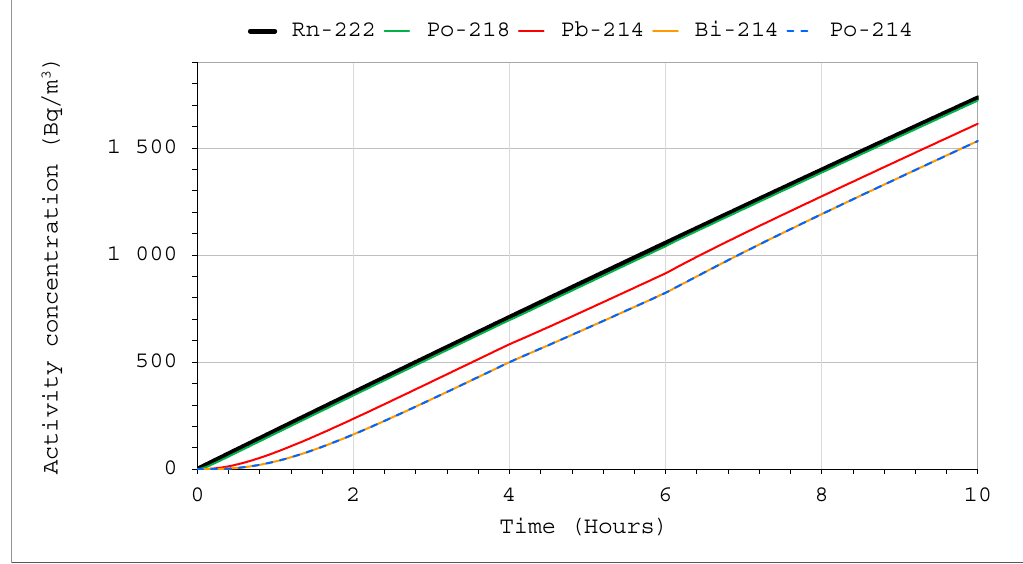
Figure 5. Activity concentration inside the system for the following conditions: E1 = 1 Bq/s (continuously), V = 20 m 3 , C oi = 0. The filtration was occurring in the range of 4–6 h with a flow rate of Q D = 10 L/min and a filtration efficiency of F = 100%.